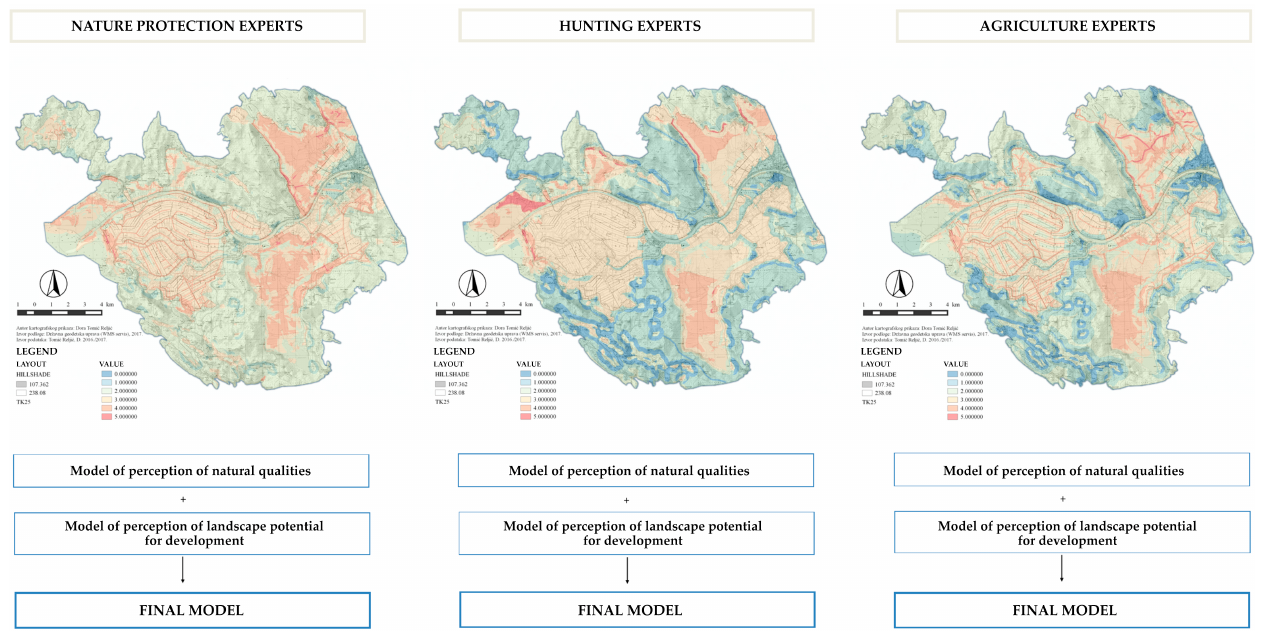
Figure 5 . The process of creating a combined model . Figure 5. The process of creating a combined